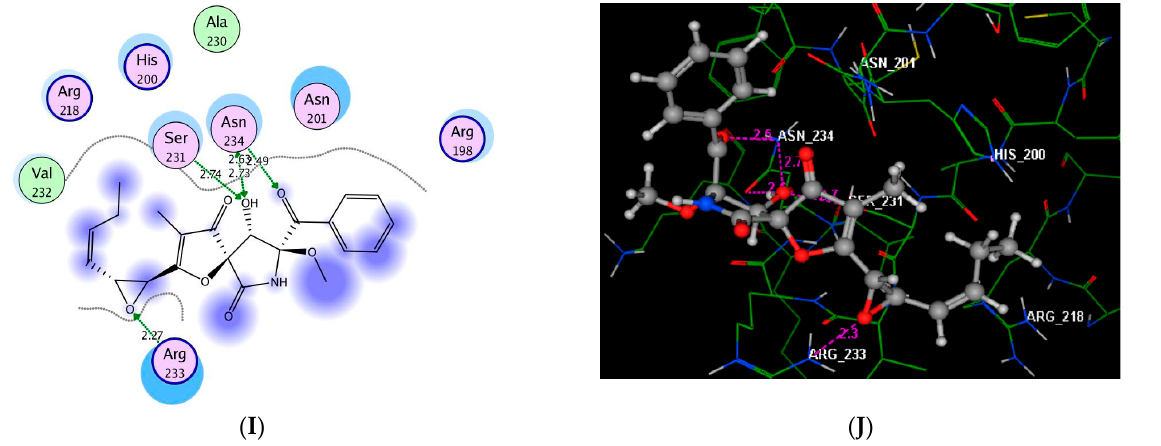
Figure 7. Illustration of the 2D ( A ) and 3D ( B ) binding patterns of Phenalinolactones A–D ( A , B ), BU–4664LMe ( C , D ), 4,5-dehydrogeldamycin ( E , F ), Questinomycin A ( G , H ), and Synerazol ( I , J ), into the ATP-active pocket of AgrA (PDB code: 3BS1 ). The hydrogen bonds are illustrated as dotted pink arrows (C atoms are colored green, S yellow and O red).